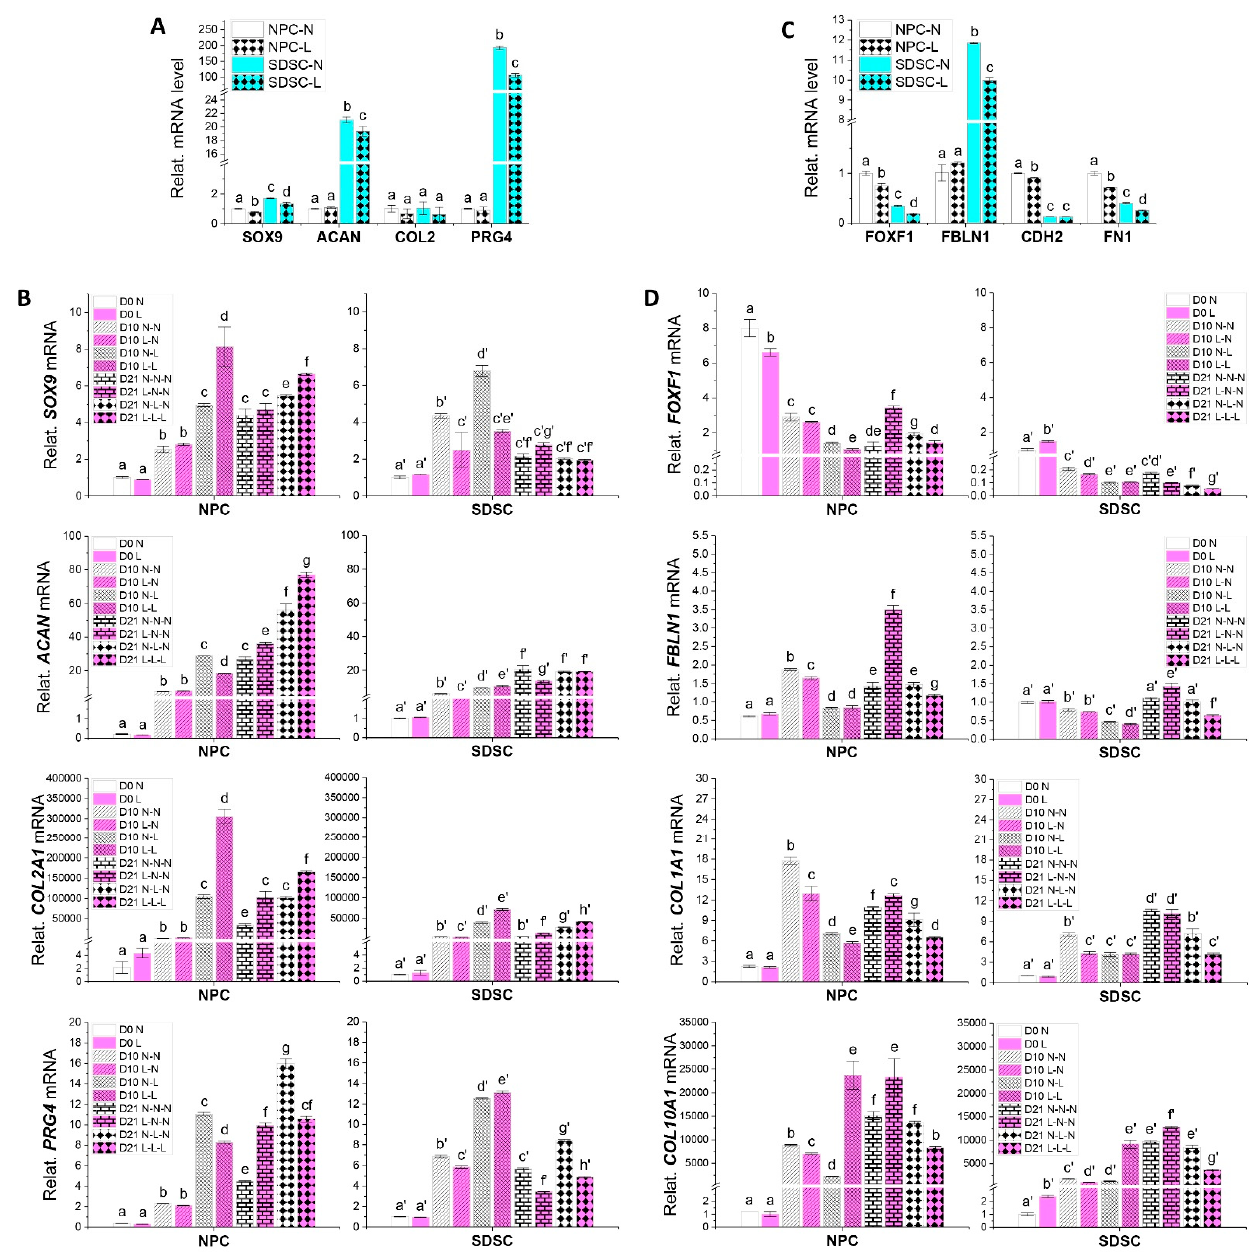
Figure 3. Evaluation of the effect of hypoxia pretreatment on chondrogenic potential of fetal MSCs using RT-qPCR. Passage 4 NPCs and SDSCs were grown to confluence in growth medium in either the normoxia (N) or hypoxia (L) environment, which were referred to as cell samples (before induc- tion). 0.4 × 10 6 cells were centrifuged to form pellets, which were then incubated in growth medium overnight before chondrogenic induction; these pellets were referred to as chondrogenic day 0 pellets (D0). Day 10 (D10) and Day 21 (D21) pellets were collected during 21-day chondrogenic induc- tion with varied hypoxia treatment. Assessment of key chondrogenic marker genes SOX9 , ACAN , COL2A1 , and PRG4 before ( A ) and after chondrogenic induction ( B ). Chondrogenic-associated genes FOXF1 , FBLN1 , CDH2 , and FN1 were also assessed before ( C ) and after chondrogenic induc- tion ( D ), normalized against GAPDH levels as an internal control. Data ( n = 4) are represented in bar charts. Different letters indicate a statistically significant difference compared to the groups within the same cell type ( p < 0.05).